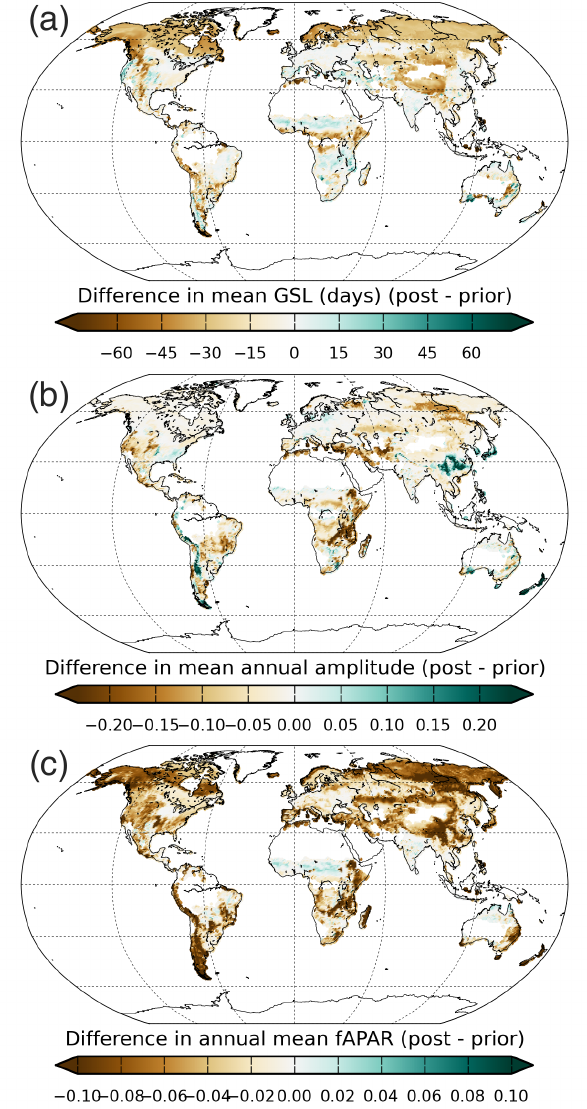
mean (over the 1990–2010 period) (a) GSL (days); (b) amplitude of the normalised fAPAR (range 0–1) and (c) mean normalised fA-